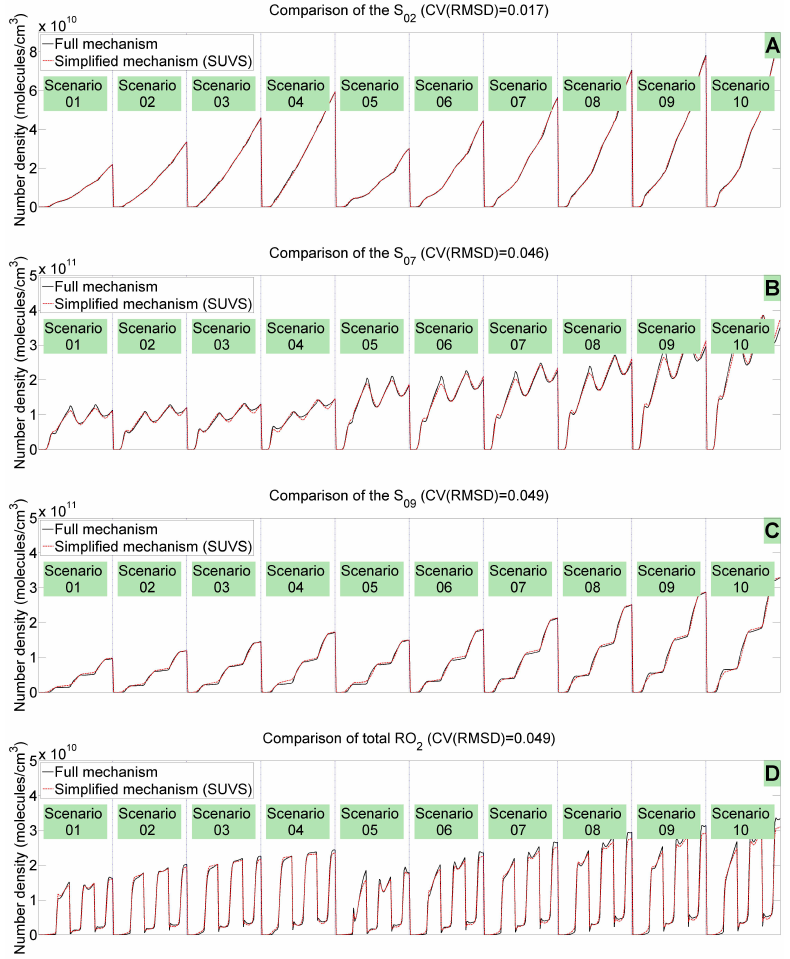
Fig. 5. Comparison of number density profiles for four representative species (S 02 , S 07 , S 09 , and RO 2 ) between the full mechanism of the MCM v3.1 and the simplified chemical mechanism (SUVS), which is obtained by using the genetic algorithms generated best set of data from the 21,549th generation. The calculated CV(RMSD) for the four species are 0.017, 0.046, 0.049, and 0.049.